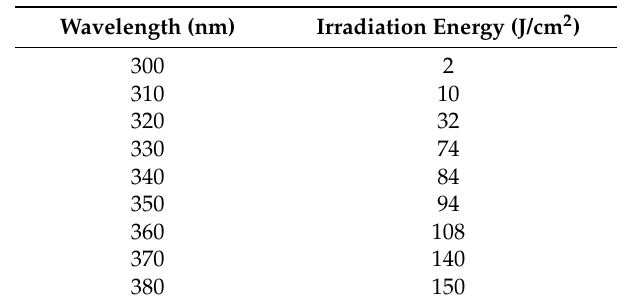
Table 2. Spectral irradiation energy with a band pass filter of the radiation from the Light Source Lightning Cure LC6 (Xe lamp